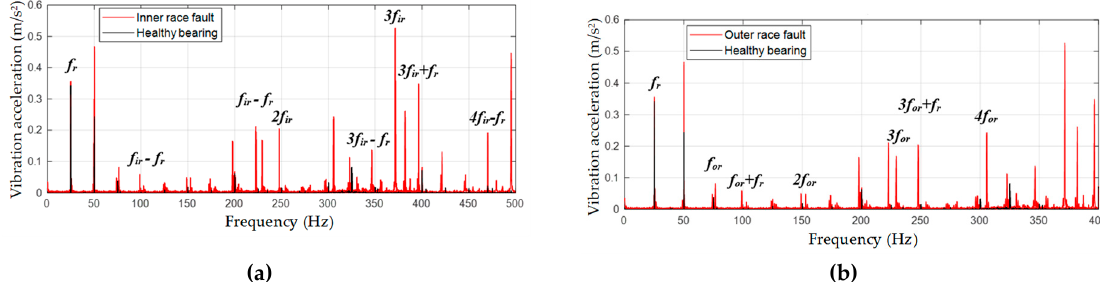
Figure 6. Examples of vibration spectra for damage to the inner (a) and outer (b) raceways for the supply frequency f s = 100 Hz of the permanent magnet synchronous motor (PMSM) drive.